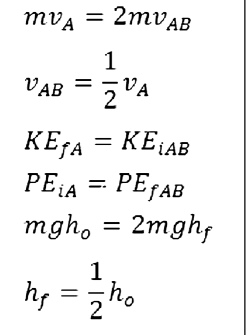
FIG. 1. An example of an introductory student’s answer to the putty (transfer) problem. Even though the student invoked the CM principle, he did not use this principle to find the final answer.